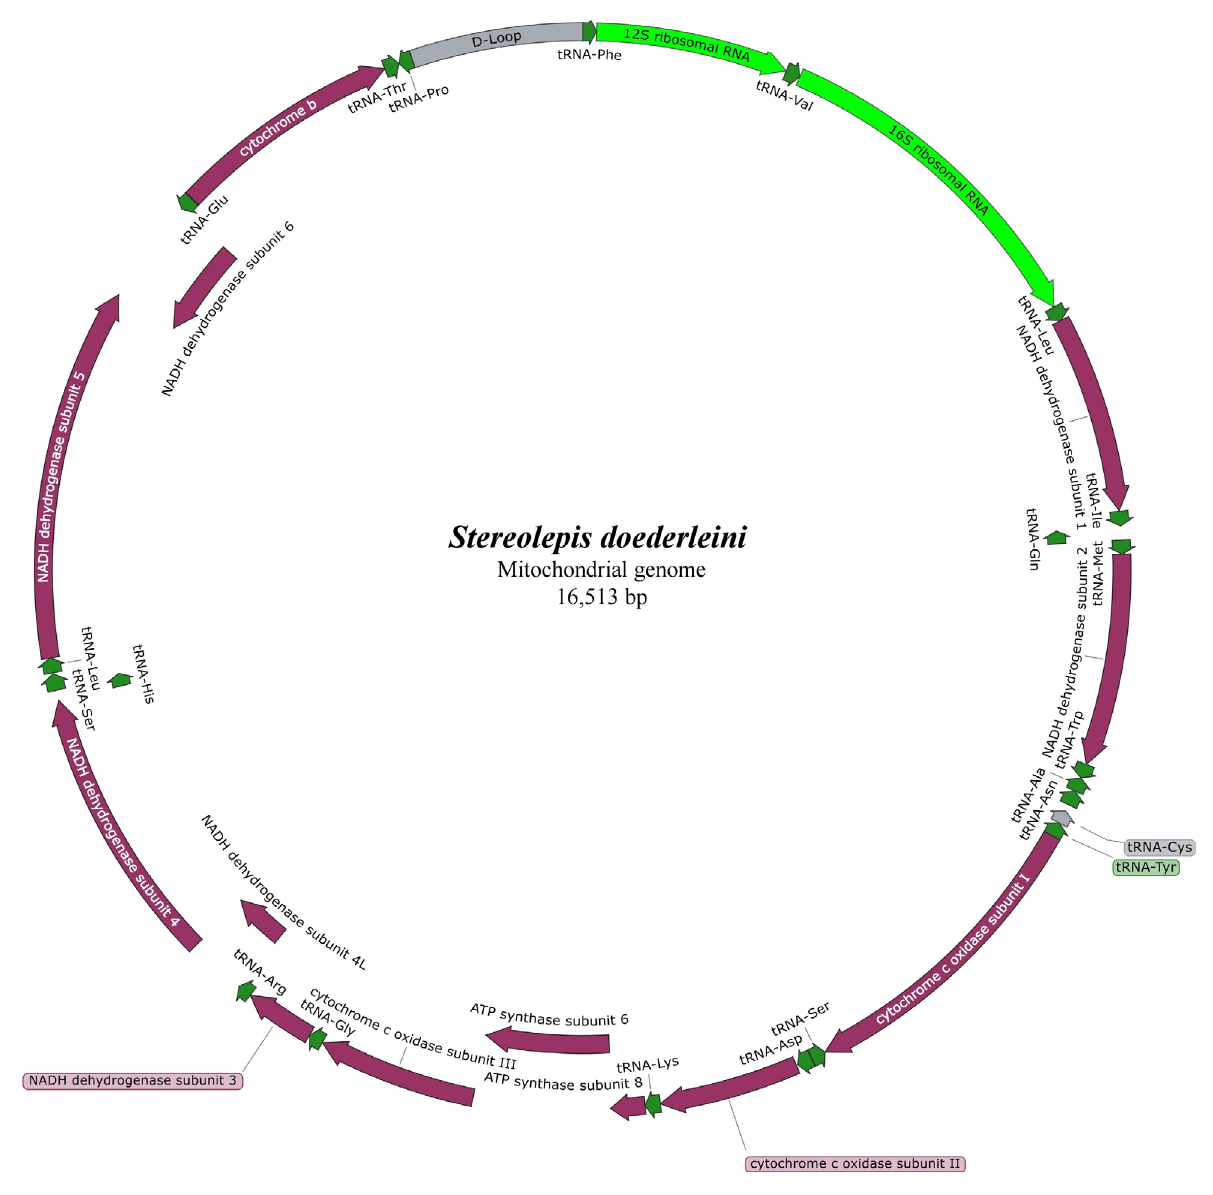
Figure 1 – Mitochondrial genome of Stereolepis doederleini . The genes and their order was identical to those of other bony